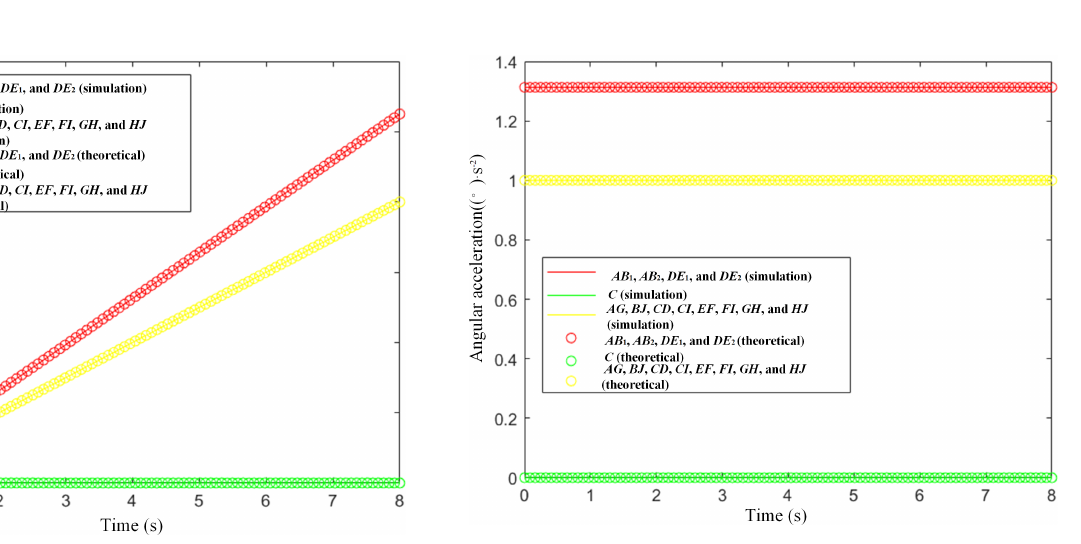
Figure 16. Acceleration of the centroid line for each component.